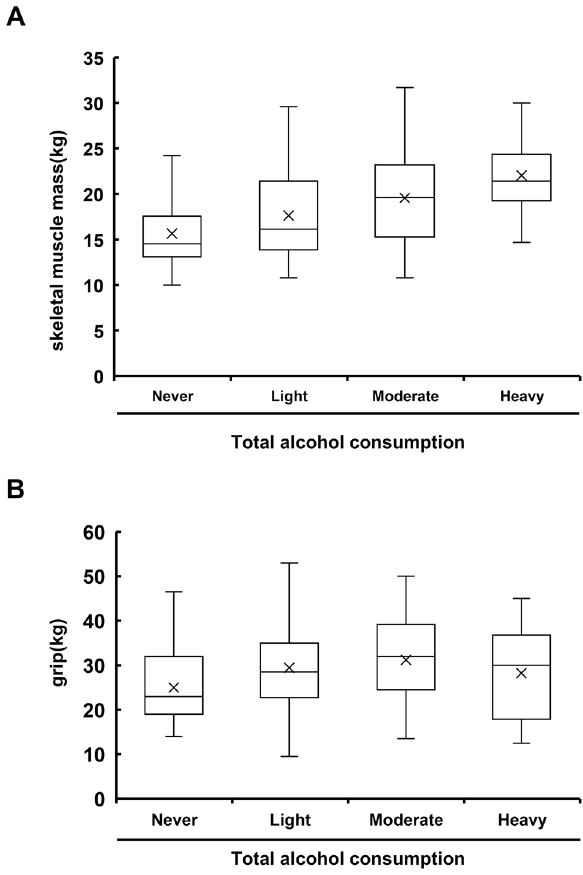
Figure 6. Skeletal muscle mass/strength is positively correlated with alcohol consumption. (A) Box and whisker plot of skeletal muscle mass for each category of alcohol intake from subjects who received health checkups in 2018 at Keio University Hospital. (B) Box and whisker plot of grip for each category of alcohol